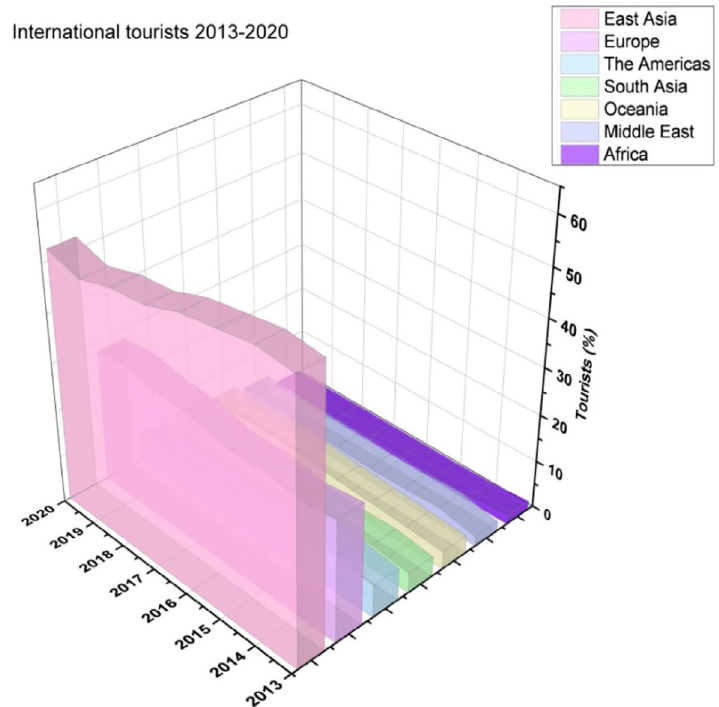
Figure 5. International tourists from 2013 until